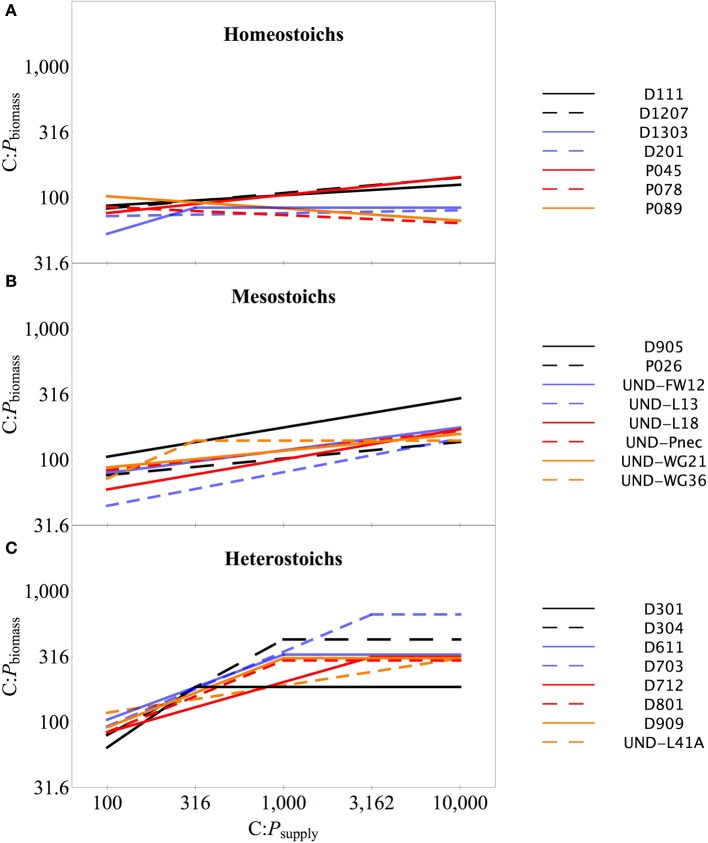
Biomass C:P stoichiometry across C:Psupply for isolates in each category. Biomass C:P stoichiometry for the isolates in each category: homeostoichs (A), mesostoichs (B), and heterostoichs (C). Lines denote the segmented linear regression as described in the text.